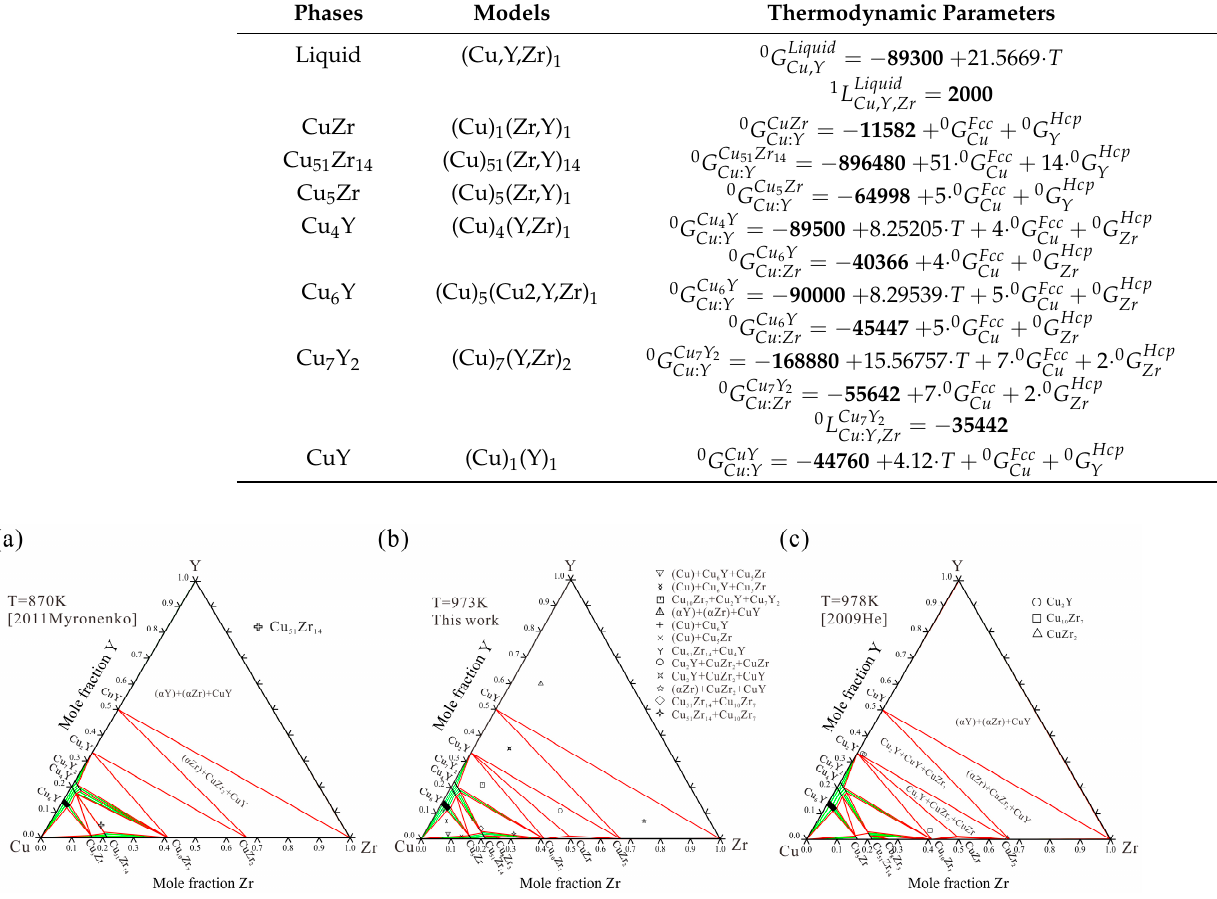
Table 3. The thermodynamic parameters obtained in this work.